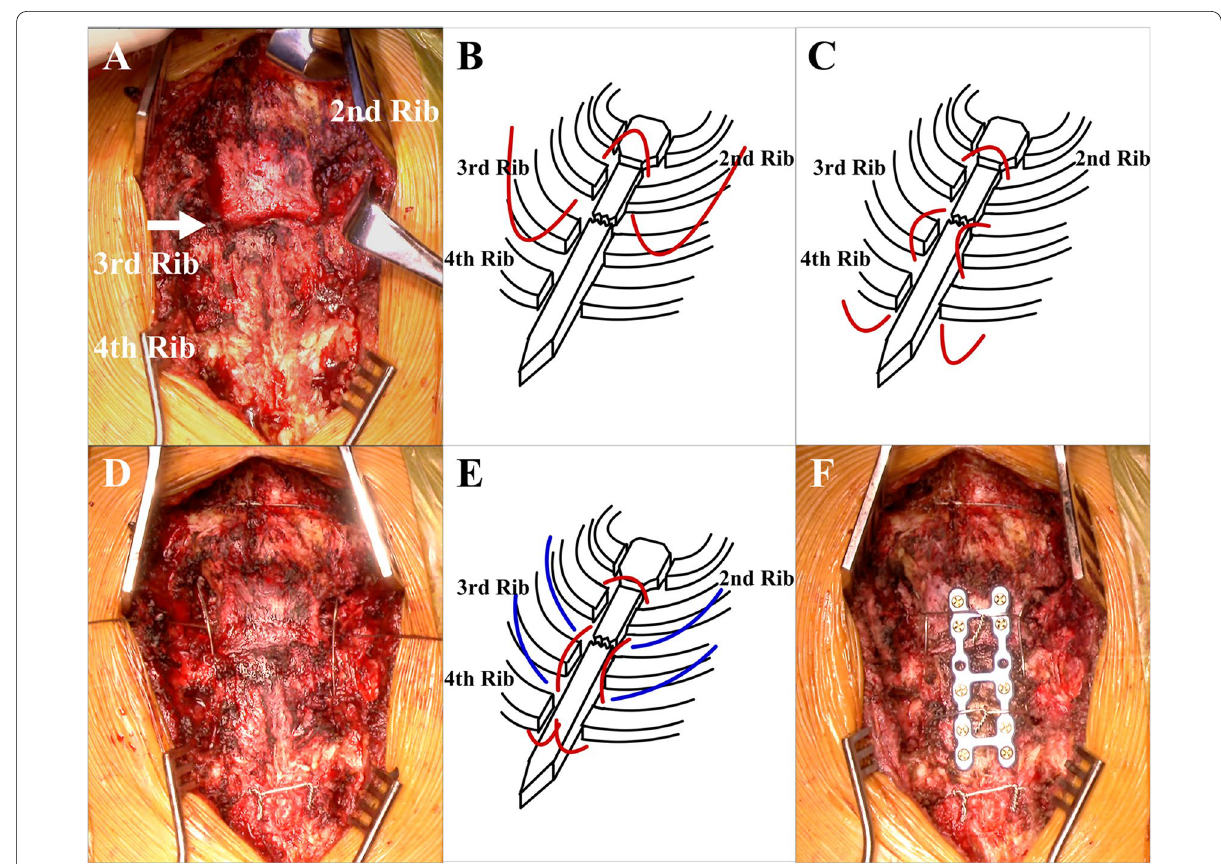
Fig. 2 Intraoperative photographs and schemas in Case 1. A The front of the sternum was exposed, and a fracture line was found at the 2nd lower intercostal margin (arrow). B , C According to the modified Robicsek technique with some minor modifications, both ends of a stainless-steel wire were advanced via the 1st intercostal space and drawn out via the 4th intercostal space, alternating from the posterior side of the 2nd rib to the anterior side of the 3rd rib and back to the poster side of the 4th rib. D , E Stainless-steel wires were passed horizontally at the 2nd and 3rd interscostals. F The front of the sternum was fixed with a 12-pin H-shaped SternaLock ® plate, and two transverse stainless-steel wires were tied in front of the sternum at the 2nd and 3rd